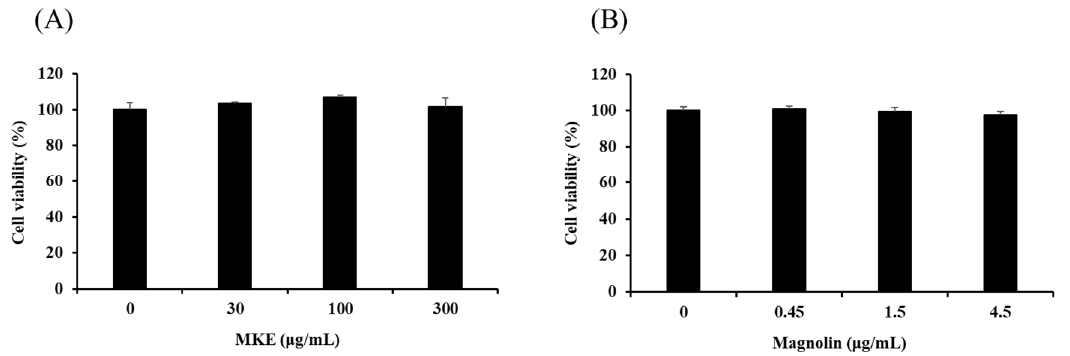
Figure 2. Effect of ( A ) MKE (0, 30, 100, and 300 μg/mL) and ( B ) magnolin (0, 0.45, 1.5, and 4.5 μg/mL) on RAW 264.7 cell viability. MKE and magnolin were used for 24 h of treatment. Values are represented as means ± standard deviation.